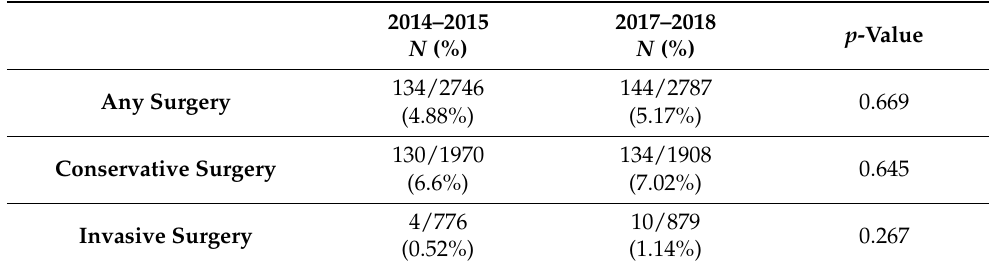
Table 1. Reintervention rates within 90 days of breast cancer surgery (period: before (2014–2015) and after (2017–2018) BU